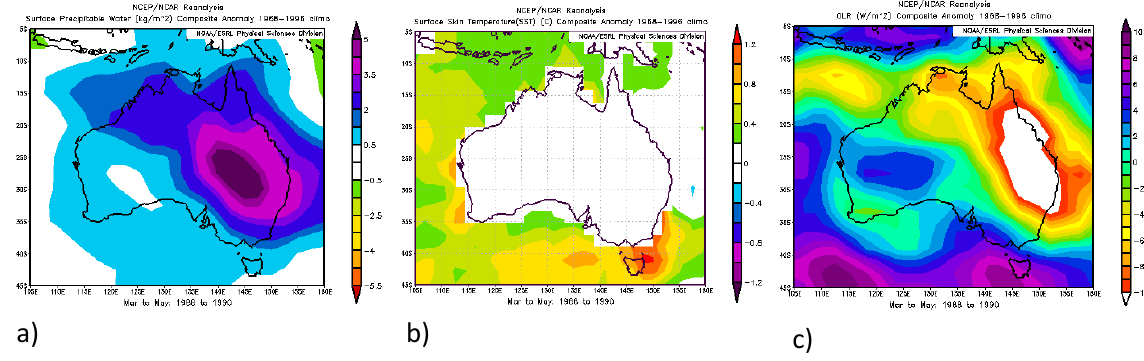
Figure 16. (a) Precipitable water anomalies, (b) SST anomalies, (c) outgoing longwave radiation, during the autumns of